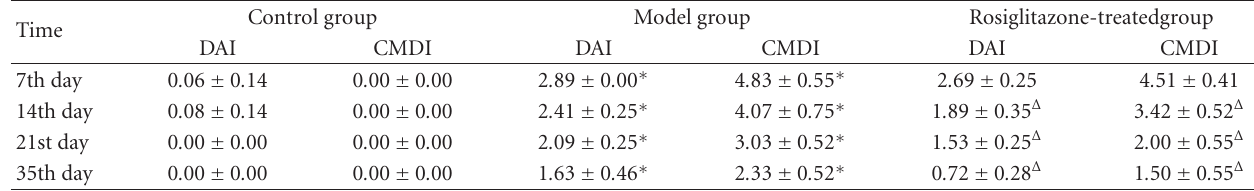
Figure 1: Pathological change of control group, UC model group, and rosiglitazone treatment group on day 14 under light microscope (HE × 200). The colonic mucosa structure was intact in the control group. Mucosa and submucosa defects could be seen with infiltrations of inflammatory neutrophils and lymphocytes in the lamina propria of the model group on day 14. The degree of mucosal inflammation relieved in the rosiglitazone treatment group on day 14. Regenerated epithelia covered the surface of ulcer and the mucosa tended to be complete. The base of ulcer was filled with tissues and scars. Table 2: DAI and CMDI of three groups on di ff erent time (mean ± SD).